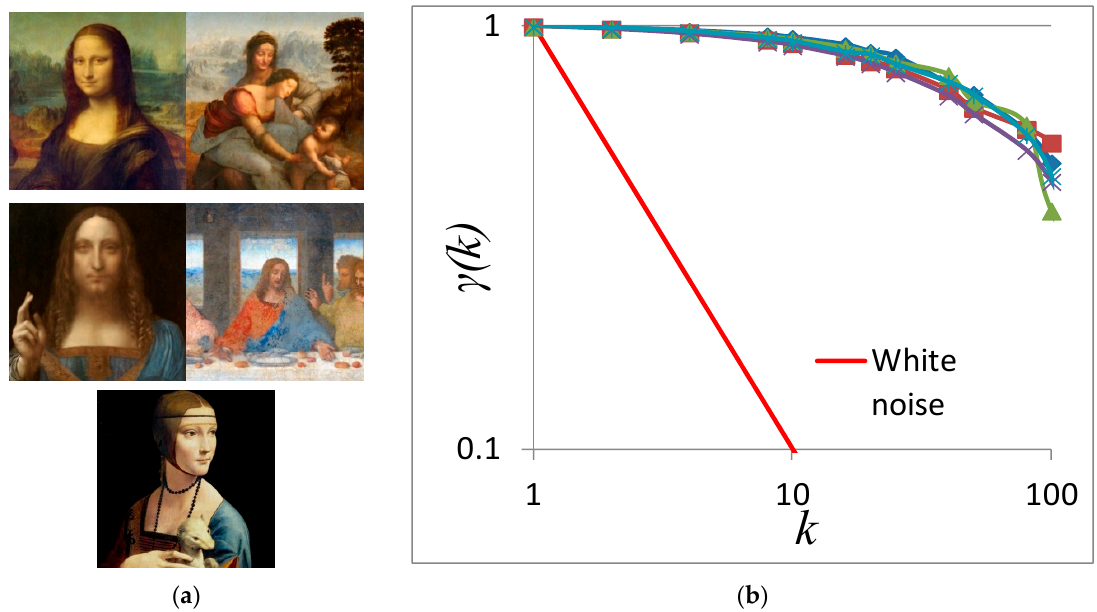
Figure 3. ( a ) Paintings of Leonardo da Vinci (1452–1519); ( b ) Standardized climacograms of the art paintings of Leonardo da Vinci.